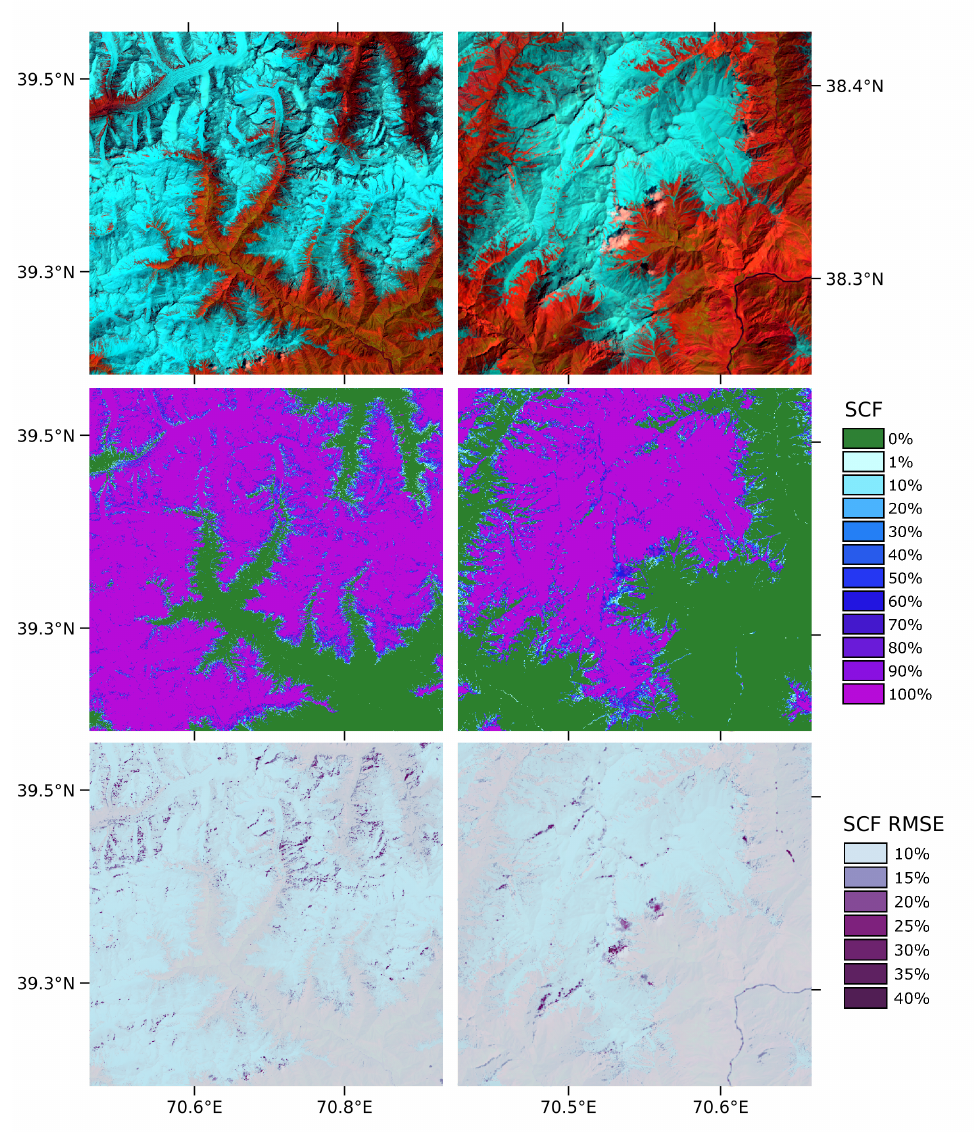
Figure A6. The left column shows the Zeravshan glacier between the Turkestan and Zarafshan mountain range near the Tajik–Kyrgyz border, and the right column shows the Darvoz mountain range in Tajikistan. First row: subsections from Landsat 8 OLI false colour composite (bands 6, 5 and 3) taken on 14 May 2013 (path 153, row 033). Second row: LAMSU SCF derived from Landsat 8 OLI data at 30 m resolution. Third row: LAMSU SCF RMSE at 30 m resolution with 90% transparency over the false colour